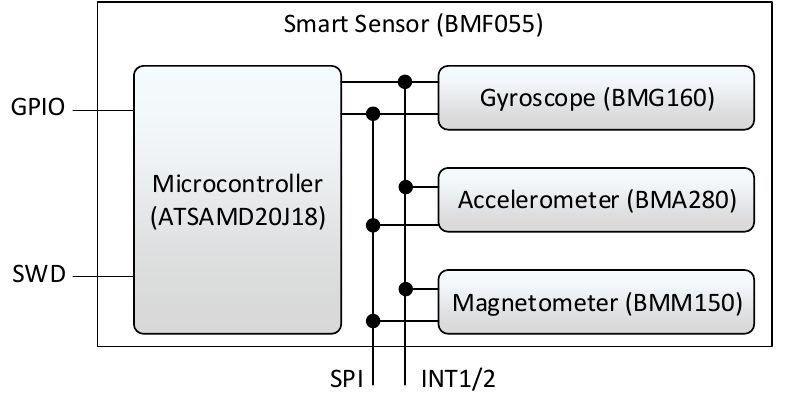
Figure 2. BMF055